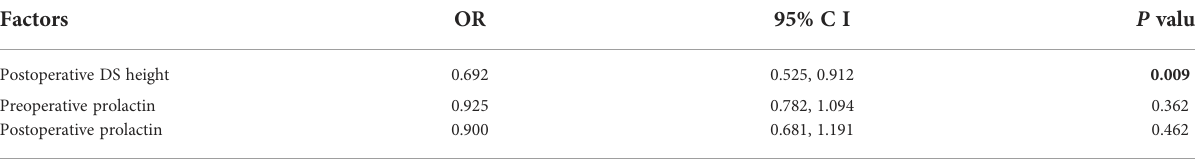
TABLE 3 Multivariate logistic regression analysis of risk of delayed postoperative hyponatremia for Rathke ’ s cleft cysts. Factors Postoperative DS